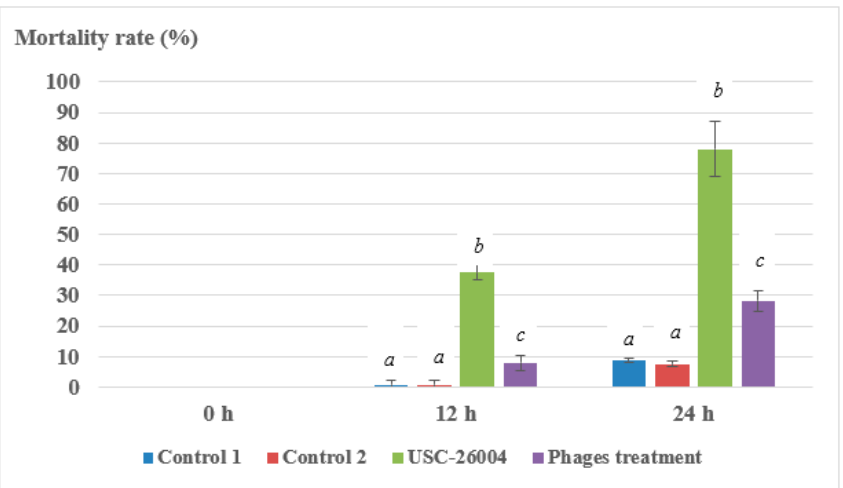
Figure 6. Mortality rate (%) of oyster ( Saccostrea glomerata ) larvae when challenged with USC-26004 and treated with a bacteriophage cocktail. The bacteriophage cocktail was composed of a 1:1:1 mixture of the bacteriophages Φ -5, Φ -6 and Φ -7. Control 1 (mixed phages cocktail), control 2 (larvae only with sterile seawater). Letters (a, b, and c) donate statistically significant differences between treatments versus time among the same types of applications.